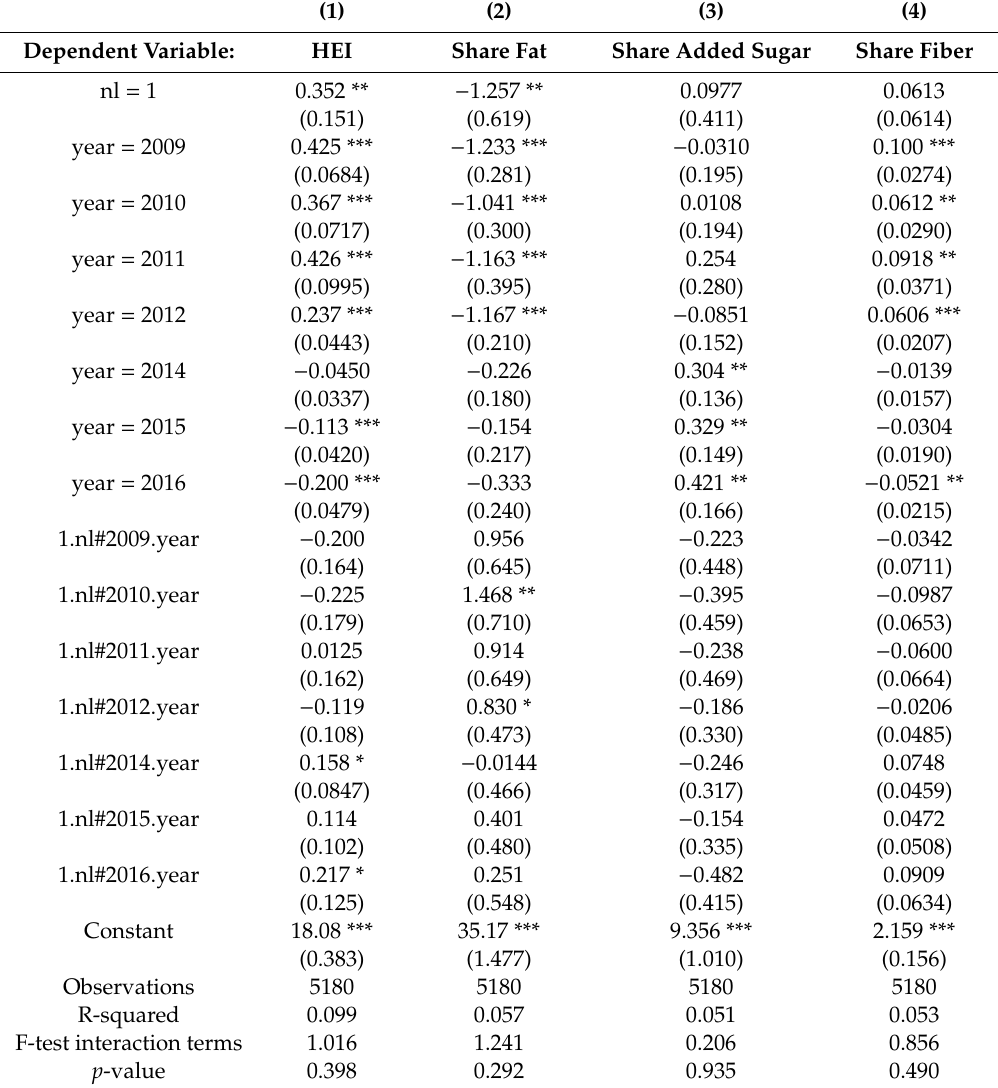
Table A4. Test of common trend of NL switchers and non-user control